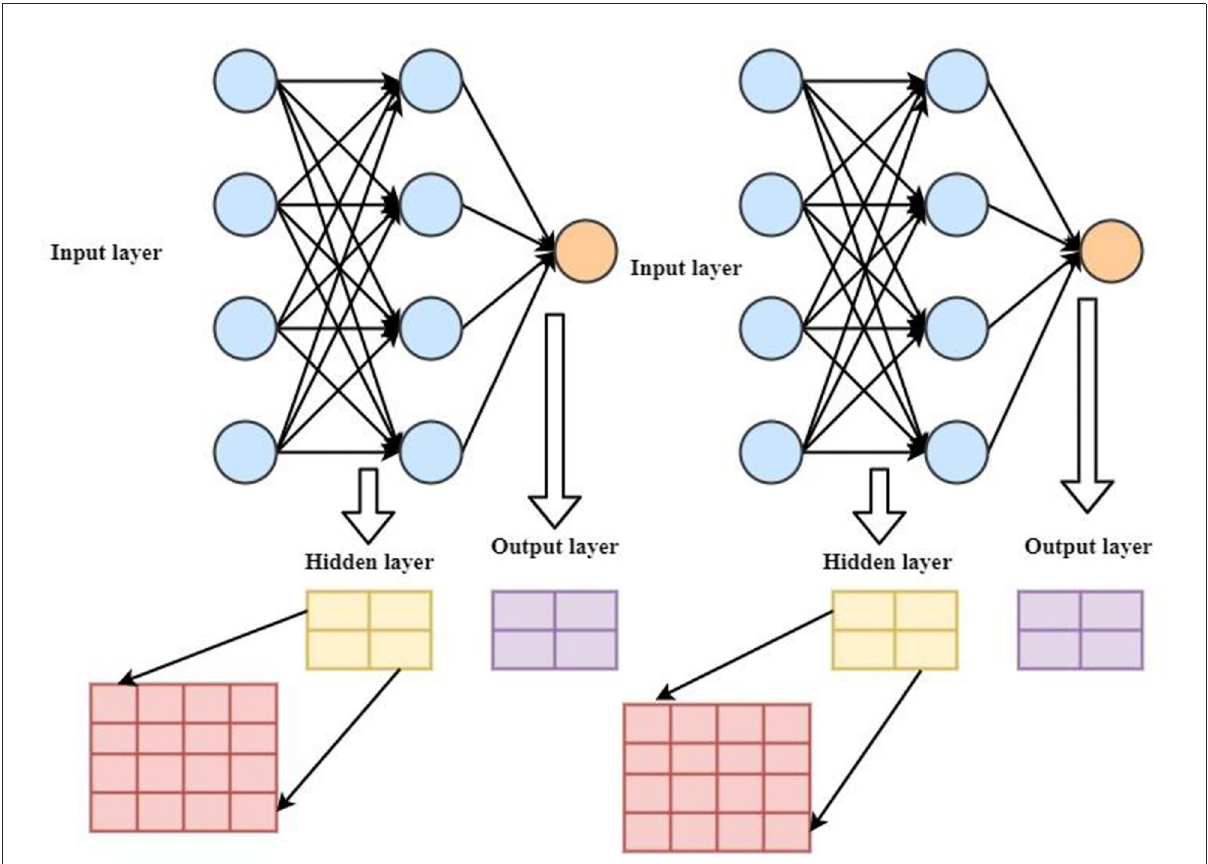
FIGURE3 Systematic model of the proposed intelligent m-Health monitoring system